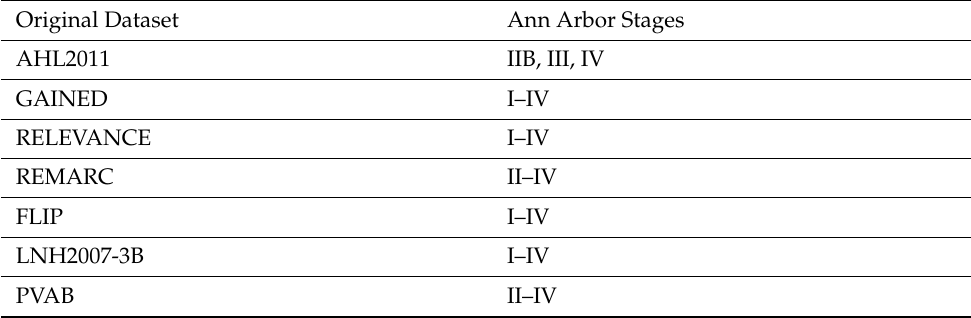
Table 1. Ann Arbor stages in the patient